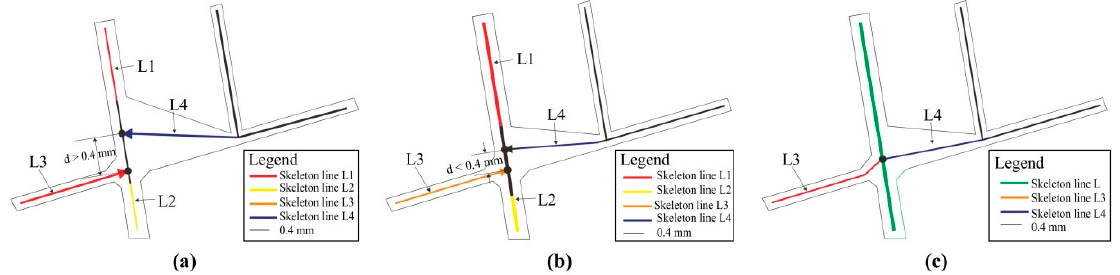
Figure 10. Re-aggregation of extended lines: ( a ) inter-node distance > TD, ( b ) inter-node distance < TD and ( c ) re-aggregated the skeleton line.